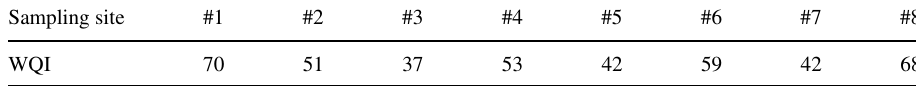
Table 8 NSF-WQI results for the sampling sites